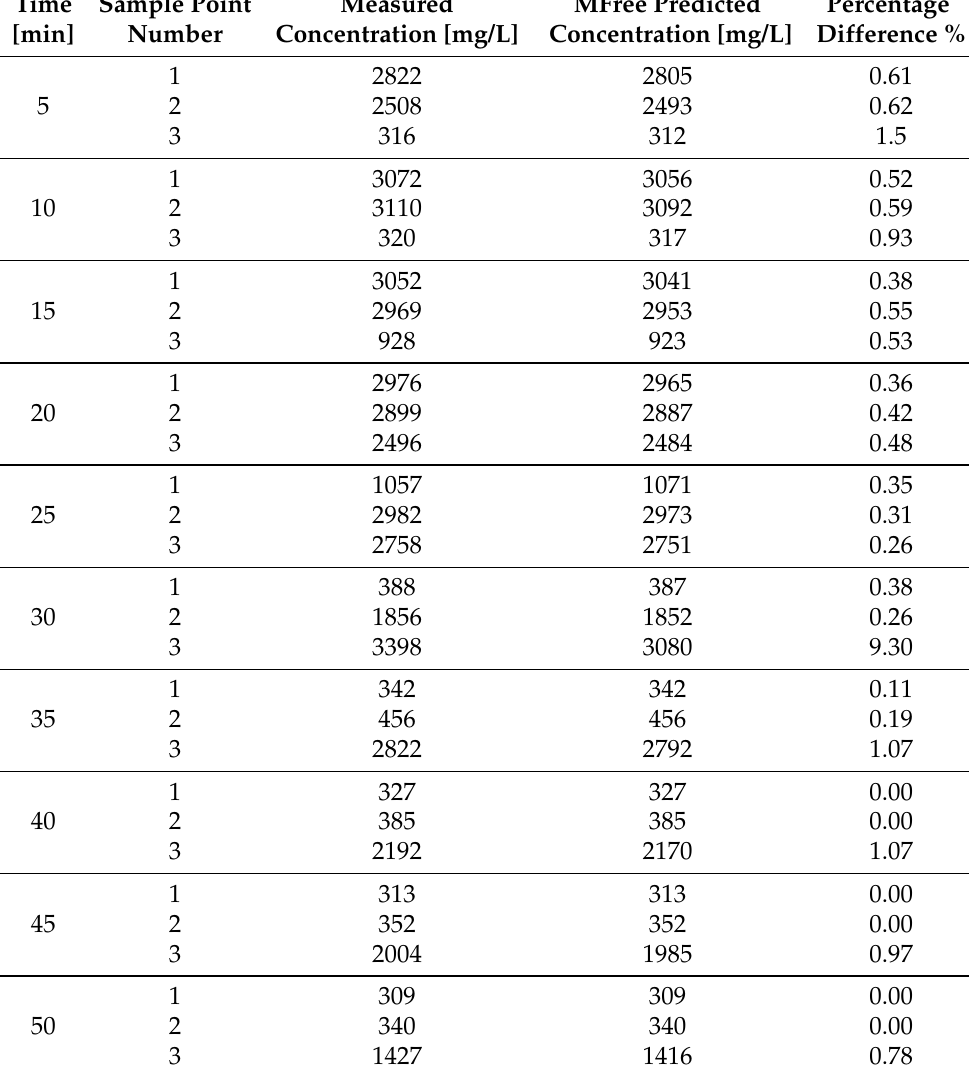
Table 3. Comparison of permanganate-measured concentration at sampling points to FD-predicted